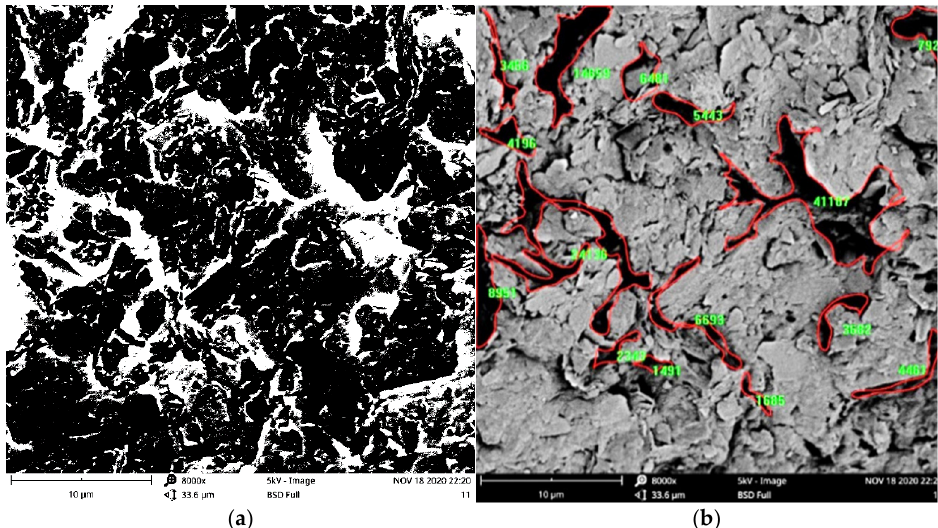
Figure 4. IPP picture processing [16]: ( a ) binary; ( b ) identification of porosity units ( The pore contour and area are marked ) .